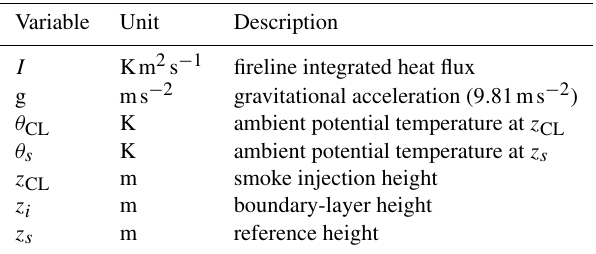
Table D1. Variable descriptions and units used in the smoke injec- tion